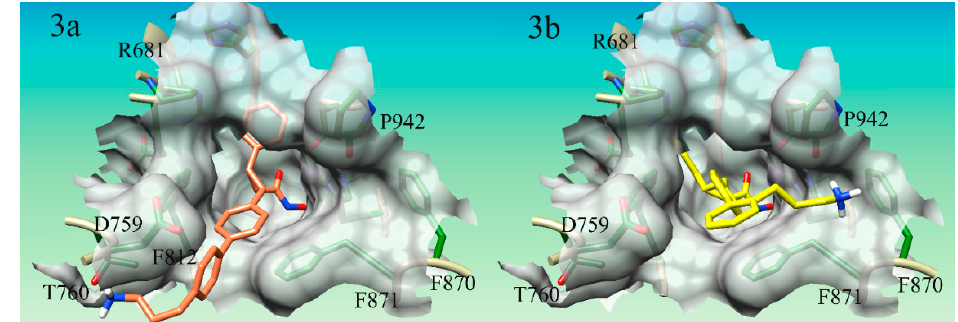
Figure 3. Docking pose of compounds S15d-06 and S15d-07 in HDAC4. ( 3a ) Compound S15d-06 (salmon) in HDAC4 active site. Cationic nitrogen on the derivative is shown hydrogen bonding with T670 on the rim of the active site; ( 3b ) Compound S15d-07 (yellow) in HDAC4 active site. The cationic nitrogen is shown forming a cation-pi interaction with F870 on the rim of the active site.